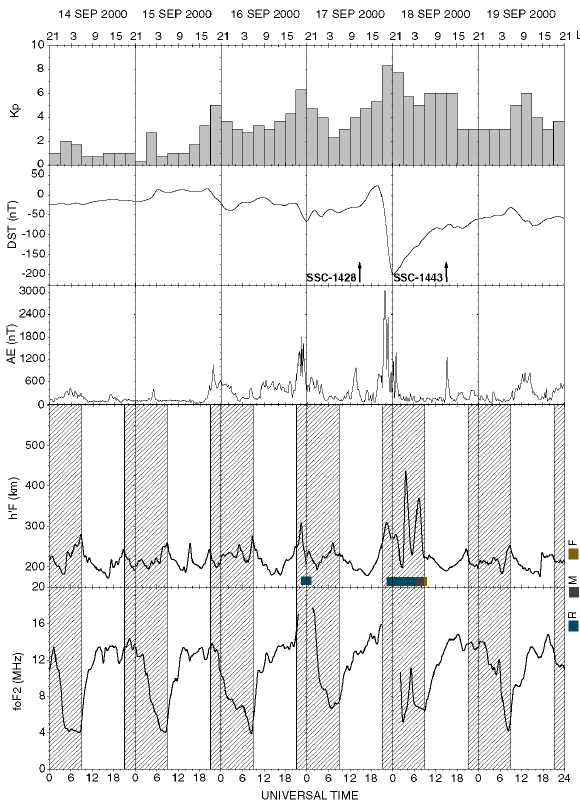
Fig. 2a. The variations of the K p , D st and AE geomagnetic indices and ionospheric parameters h 0 F and fo F2 observed at Sao Jose dos Campos during the period of 14 to 19 September 2000. The peri- ods of spread-F (range R, mixed M and frequency F) are shown by horizontal bars.